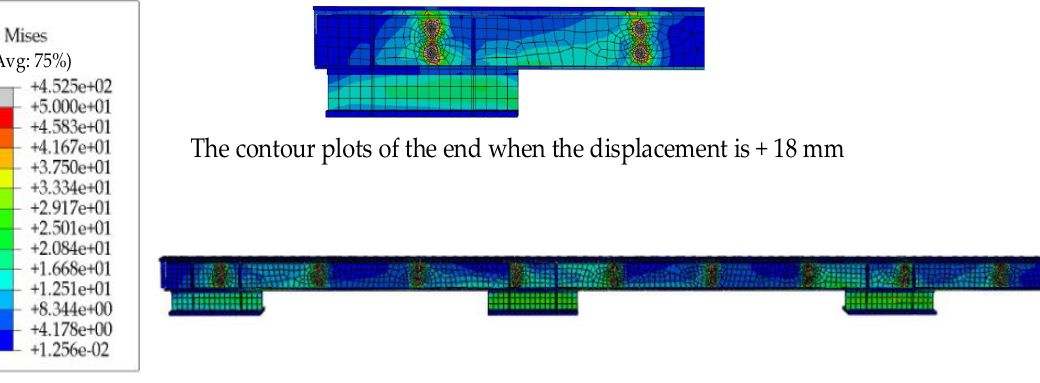
Figure 13. The contour plots of the finite element model results (based on SJ1).